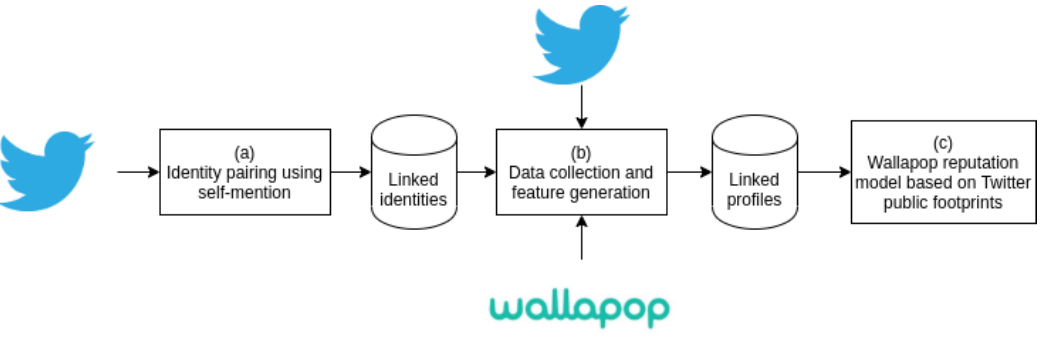
Figure 2. Proposed methodology to build a model for reputation